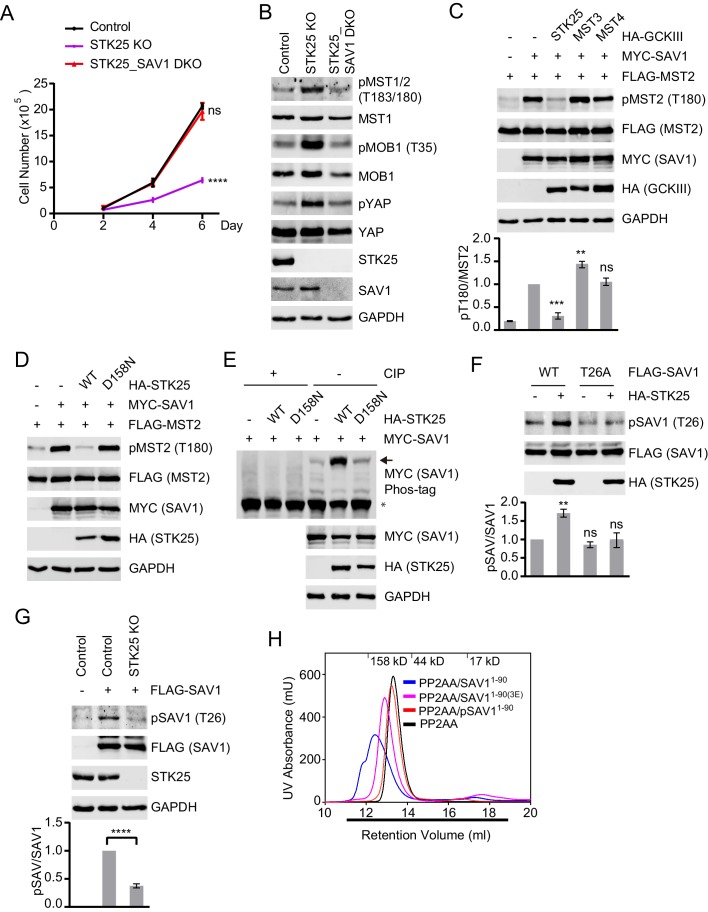
STK25 inhibits the ability of SAV1 to counteract STRIPAK.(A) Cell proliferation assay. Cell proliferation curves in control (black), STK25 KO (purple), and STK25_SAV1 DKO (red) 293A cells were plotted, respectively. Cells were counted on days 2, 4, and 6 after seeding. Data shown are the means ± SEM of three independent experiments. Numbers of STK25 KO or STK25_SAV1 DKO cells on day 6 was compared to that of control cells (****p<0.0001; ns, non-significant). (B) Immunoblots of control, STK25 KO, and STK25_SAV1 DKO 293A cell lysates with the indicated antibodies. (C) Immunoblots of lysates of 293FT cells co-transfected with FLAG-MST2 and the indicated plasmids. The relative anti-pT180 intensities were normalized to MST2. Data are plotted as mean ± SEM of three biological replicates (***p<0.001; **p<0.01; ns, non-significant). (D) 293FT cells were co-transfected with FLAG-MST2 and the indicated plasmids. The total cell lysates were subjected to immunoblotting. (E) 293FT cells were co-transfected with MYC-SAV1 and HA-STK25. The cell lysates were treated with or without CIP (Calf Intestinal Alkaline phosphatase). CIP-treated and non-CIP-treated lysates were subjected to phos-tag gel analysis and immunoblotting. Asterisk and arrow designate non-phosphorylated SAV1 and phosphorylated SAV1, respectively. (F) Immunoblots and quantification of phosphorylated SAV1 (T26) levels of 293FT cells co-transfected with the indicated plasmids. (G) Control and STK25 KO 293A cells were transfected with FLAG-SAV1. The total cell lysates were blotted with the indicated antibodies. (F and G) The relative anti-pSAV1 intensities were normalized to SAV1. Data are plotted as mean ± SEM of three biological replicates (****p<0.0001; **p<0.01; ns, non-significant). (H) UV traces of the PP2AA and SAV11-90 complex (blue line), PP2AA and phosphorylated-SAV11-90 mixture (pSAV11-90, red line), PP2AA and SAV11-90(3E) mixture (magenta line), and PP2AA alone (black line) fractionated on a Superdex 200 gel filtration column, respectively. Corresponding molecular weight standards are indicated in kDa. The running buffer for Superdex 200 column containing 20 mM Tris (pH 8.0), 30 mM NaCl, and 1 mM TCEP. The underlined fractions were separated on SDS-PAGE and stained with Coomassie shown in Figure 3—figure supplement 1E.